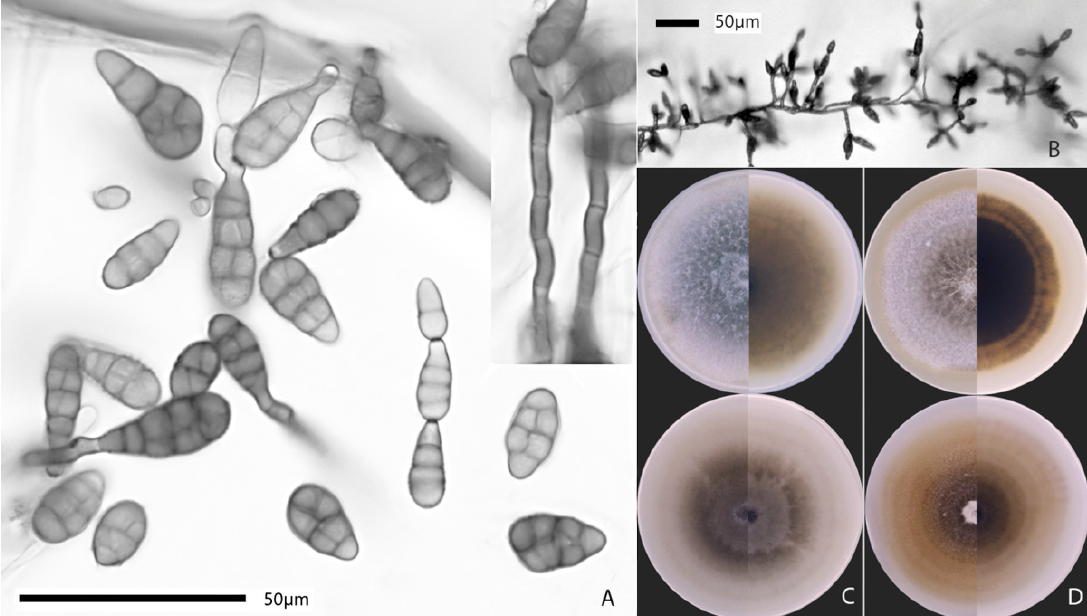
Figure 2. Morphology of Alternaria sect. Pseudoalternaria strains. Conidia ( A ) and conidiophores ( B ) of A. kordkuyana MF P094121 after 5–7 days of incubation on potato carrot agar under an alternating light/dark cycle. Colonies of A. kordkuyana MF P094121 ( C ) and A. rosae MF P457041 ( D ) on potato sucrose agar ( above ) and potato carrot agar ( below ), upper ( left ) and reverse ( right ) view. Colonies of A. rosae MF P457041 on PSA were 71 mm diam., flat, felty, dark gray